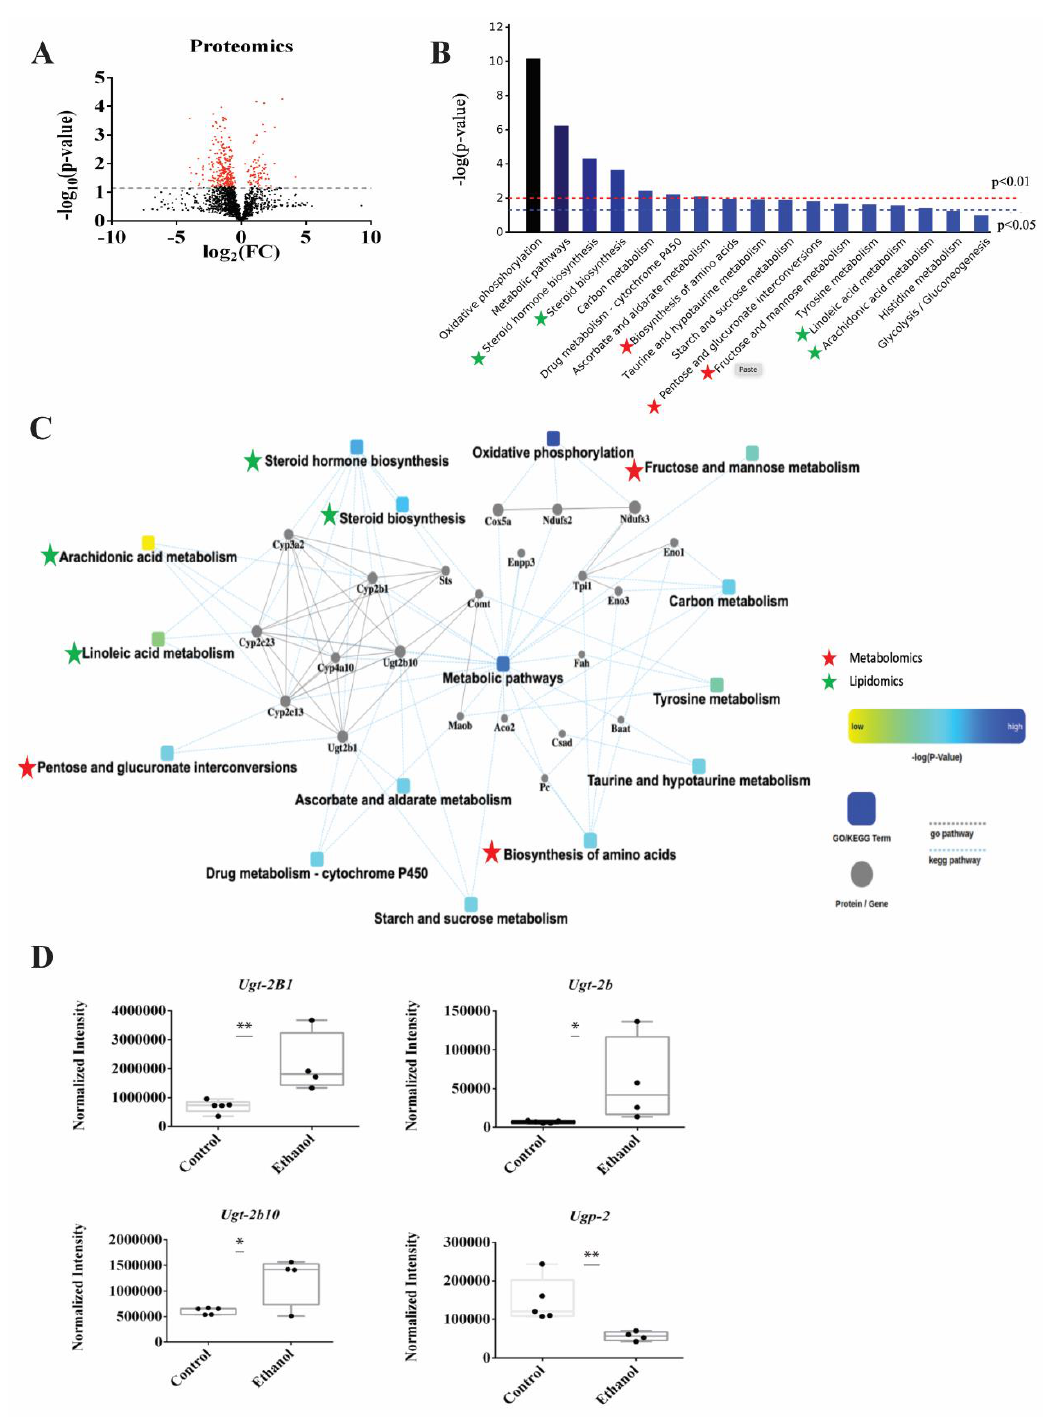
Figure 6. ( A ) A volcano plot summarizing the LC-MS proteomics data set. The dashed line identifies the p -value of 0.05. All proteins above the p -value threshold are colored red. A total of 2083 proteins were detected with 368 proteins differentially expressed ( p -value < 0.05). ( B ) A protein enrichment analysis based on the 124 differentially expressed proteins showing the most impactful 17 Kyoto Encyclopedia of Genes and Genomes (KEGG) pathways. The pathways common to both the metabolomics and proteomics data sets or both the lipidomics and proteomics data sets are marked with red and green stars, respectively. ( C ) A Cytoscape generated protein–protein interaction (PPI) network of the significantly changing ( p -value < 0.05) KEGG pathways. The pathways common to both the metabolomics and proteomics data sets or both the lipidomics and proteomics data sets are